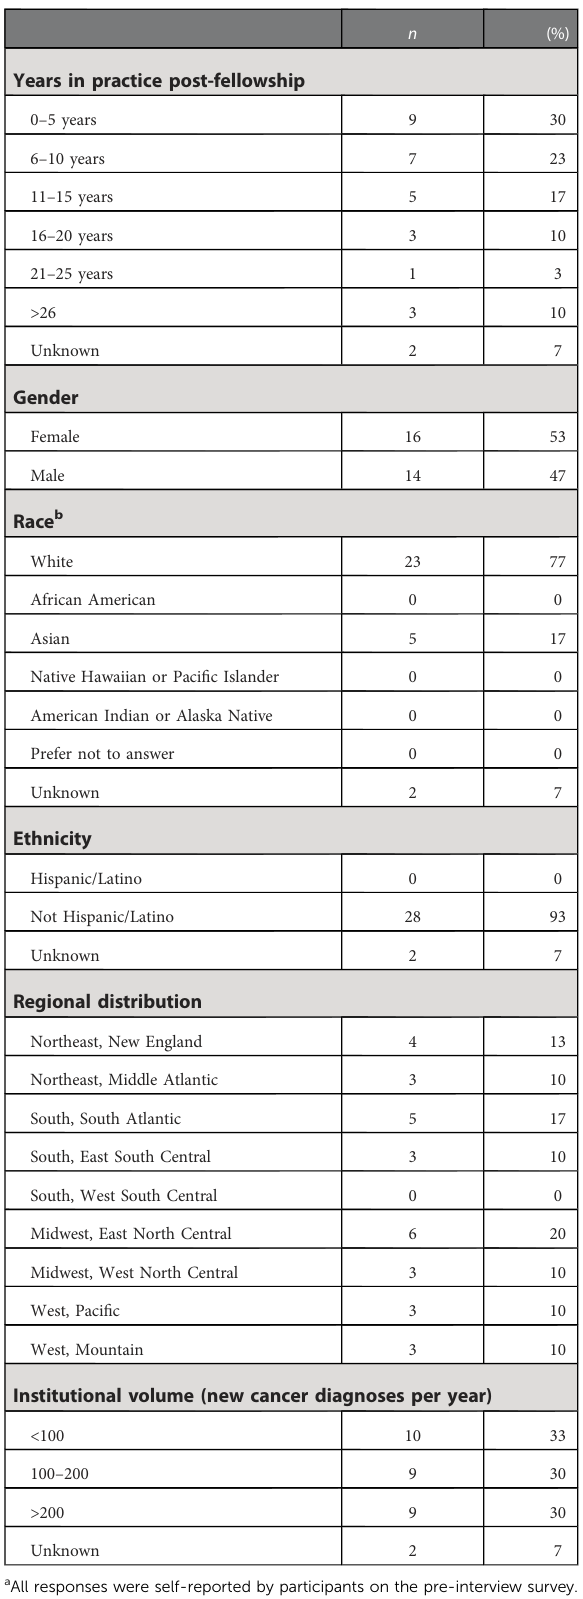
TABLE 2 Participant characteristics a ( n